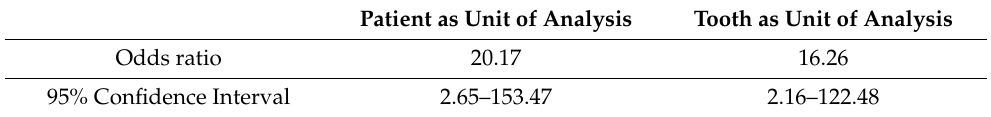
Table 2. Risk of developing alveolitis when a patient and tooth belong to Pell and Gregory class II and III. Reference category: class